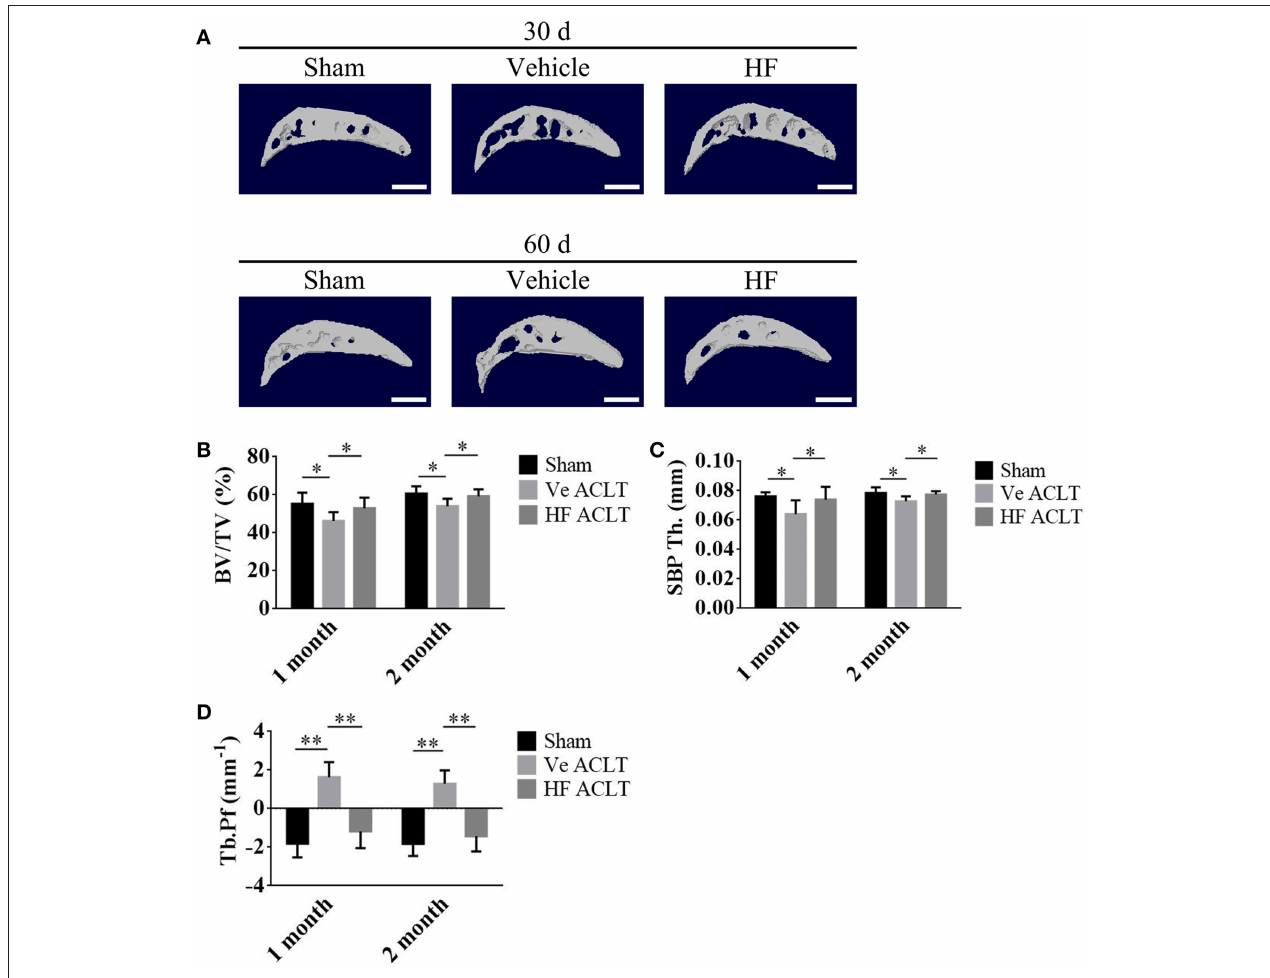
FIGURE 3 | HF maintained normal subchondral bone microarchitecture after ACLT. (A) 3D micro-CT image of tibial subchondral bone medial compartment in sagittal view at 30 and 60 d after sham surgery or ACLT. Scale bar, 500 µ m. (B–D) Quantitative analysis of micro-CT parameters of tibial subchondral bone: bone volume fraction (BV/TV) (B) , thickness of subchondral bone plate (SBP.Th.) (C) and trabecular pattern factor (Tb.Pf) (D). * p < 0.05 as denoted by bar, ** p < 0.01 as denoted by